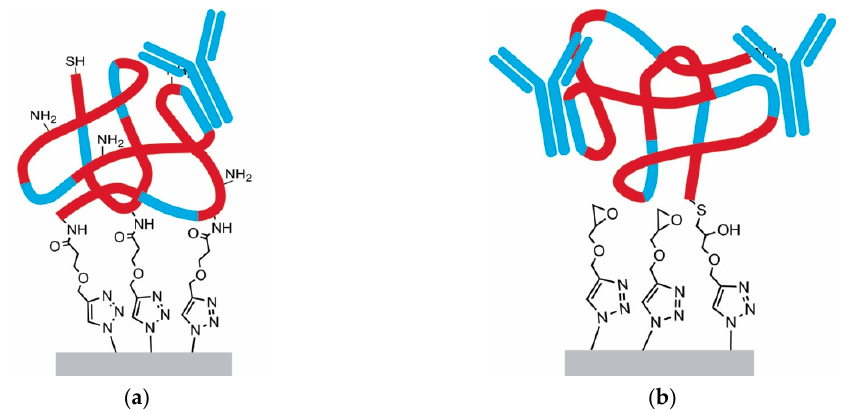
Figure 7. Illustrative comparison between multipoint attachment and single point attachment of proteins. ( a ) amidation reaction; ( b ) thiol-epoxide ring-opening reaction. proteins. ( a ) amidation reaction; ( b ) thiol-epoxide ring-opening